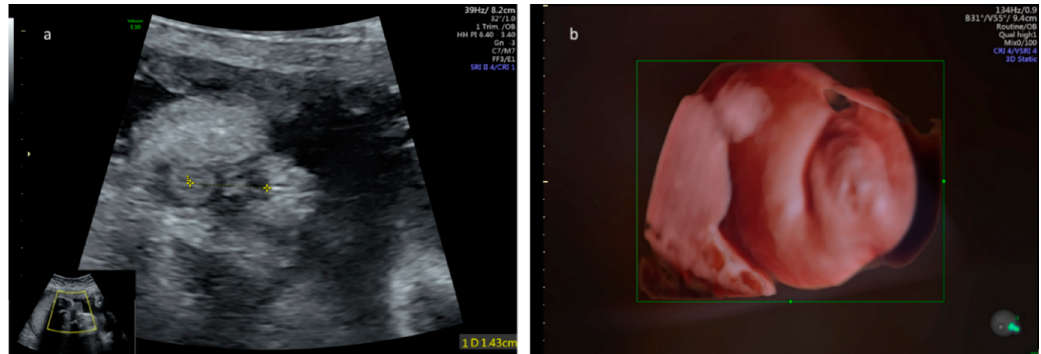
Figure 4. ( a ). Ano-genital distance measurements obtained in a PCOS-mothers’ female foetus at 28 weeks of gestation. The foetal anogenital distance correlates with the 97.5th percentile for gestational age [22]. ( b ). Three-dimensional surface render of the perineal region demonstrating mild clitoromegaly that could also be attributed to exposure to an intra-uterine increased level of androgens. Post-natal examination revealed normal genitalia with no evidence of virilization.